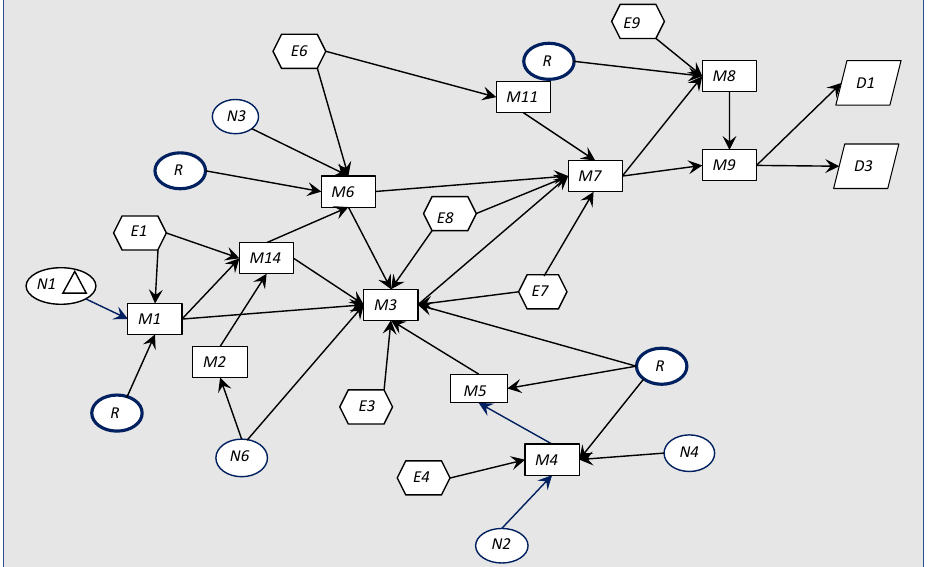
Figure 6. Superstructure for single-period injection of renewables in the Ontario natural gas grid (pipeline distance not to